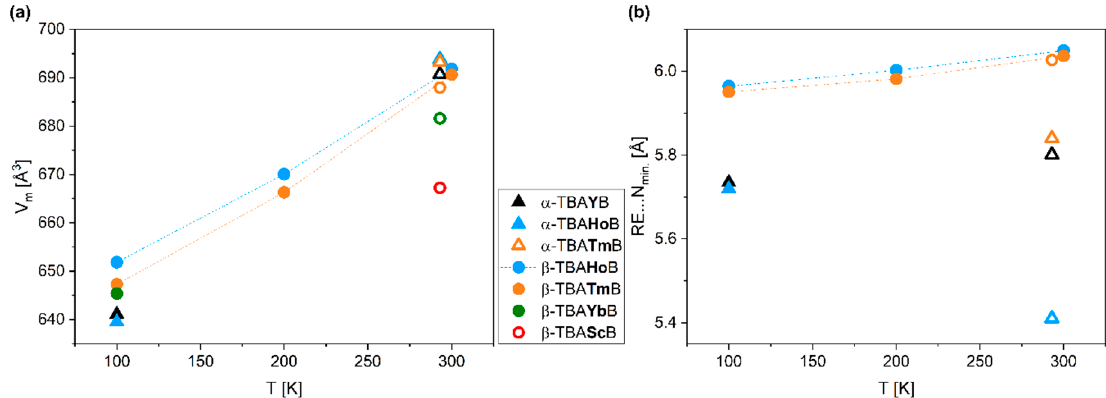
Figure 2. ( a ) Molecular volumes (V m ), and ( b ) minimal RE . . . N distances in the function of temperature for a series of TBAREB compounds in both α – and β – forms. SC-XRD data—filled symbols, PXRD data—open